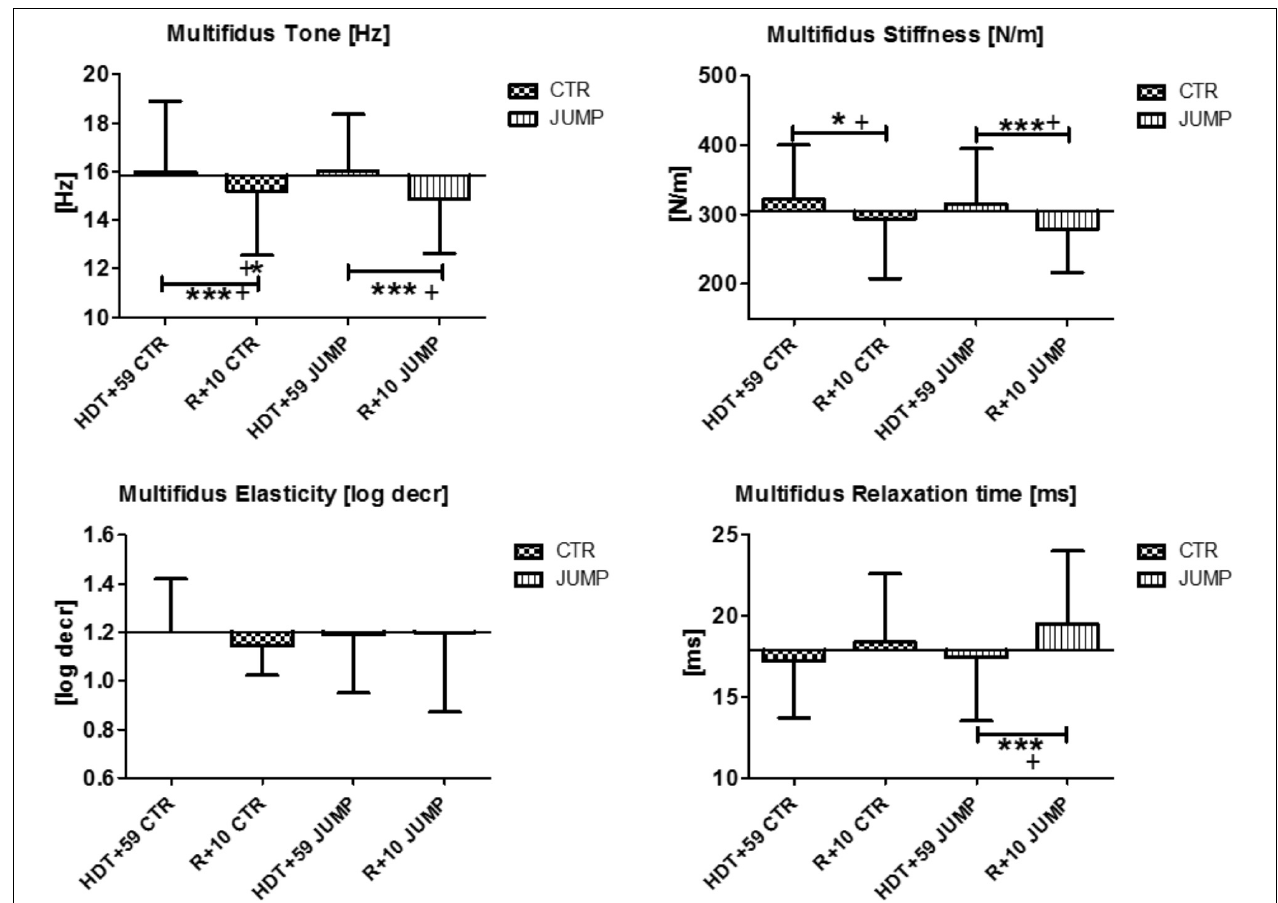
FIGURE 7 | Multifidus (MP13/14). Oscillation signal patterns in RSL bed rest study. ABD = Average baseline data (Tone HDT+1 = 15.85; Stiffness HDT+1 = 304.10; Elasticity HDT+1 = 1.2; Relaxation HDT+1 = 17.9). ∗ p < 0.05, ∗∗∗ p < 0.001 ± SD, +Spearman ρ